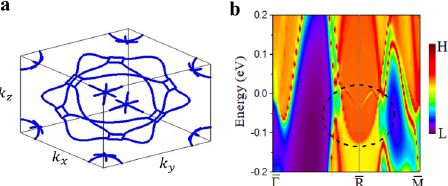
Fig. 3 The crossing nodal-lines and topological surface states. a The distribution of the Dirac points without spin-orbit coupling in the fi rst Brillouin zone. Crossing nodal-lines are observed. b The drumhead surface state on the (010) surface at the R point around the Fermi level. The spin-orbit coupling is included.